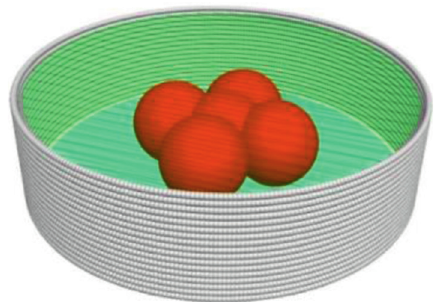
Figure 8: Measurement balls (red) in a DEM sample.